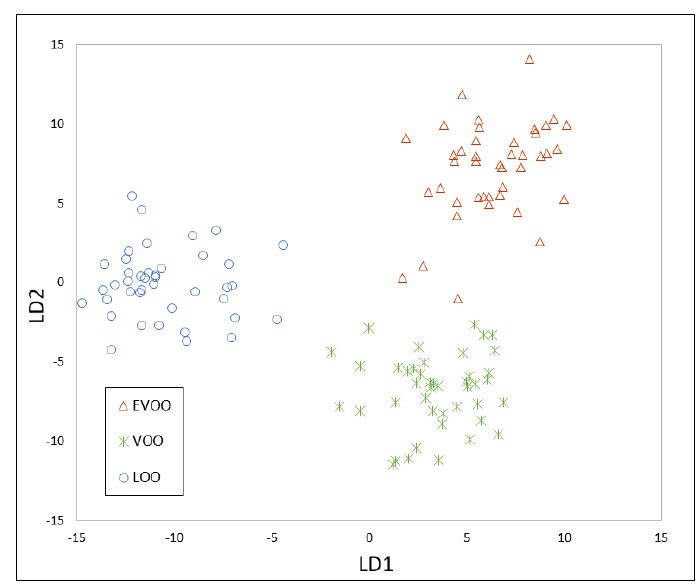
Figure 5. PCA-LDA model constructed using the TIC of the HS-GC-MS method.